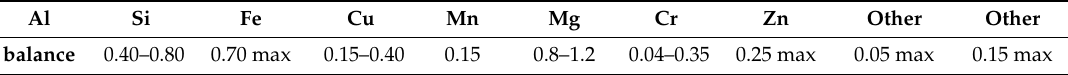
Table 2. Chemical composition of AA6061 (weight %).